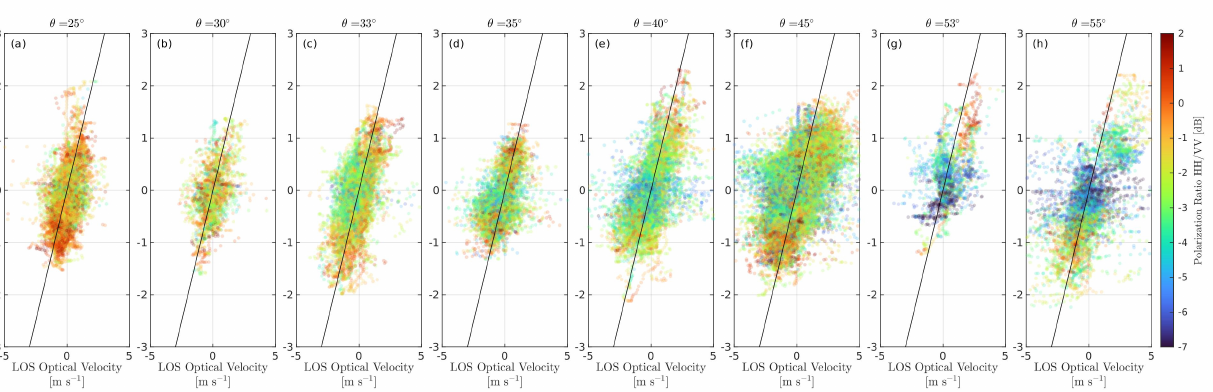
Figure 4. Scatterplots between the measured line-of-sight optical velocity (LOV) and Doppler velocity (DV) at VV polarization for the “instant” dataset (all breaking stages) at different incidence angles: ( a ) θ = 25 ◦ , ( b ) θ = 30 ◦ , ( c ) θ = 33 ◦ , ( d ) θ = 35 ◦ , ( e ) θ = 40 ◦ , ( f ) θ = 45 ◦ , ( g ) θ = 53 ◦ , and ( h ) θ = 55 ◦ . Each point corresponds to an instantaneous video frame during a breaking event. The symbol color corresponds to the polarization ratio, HH/VV, in the logarithmic scale. Black diagonals show the x = y